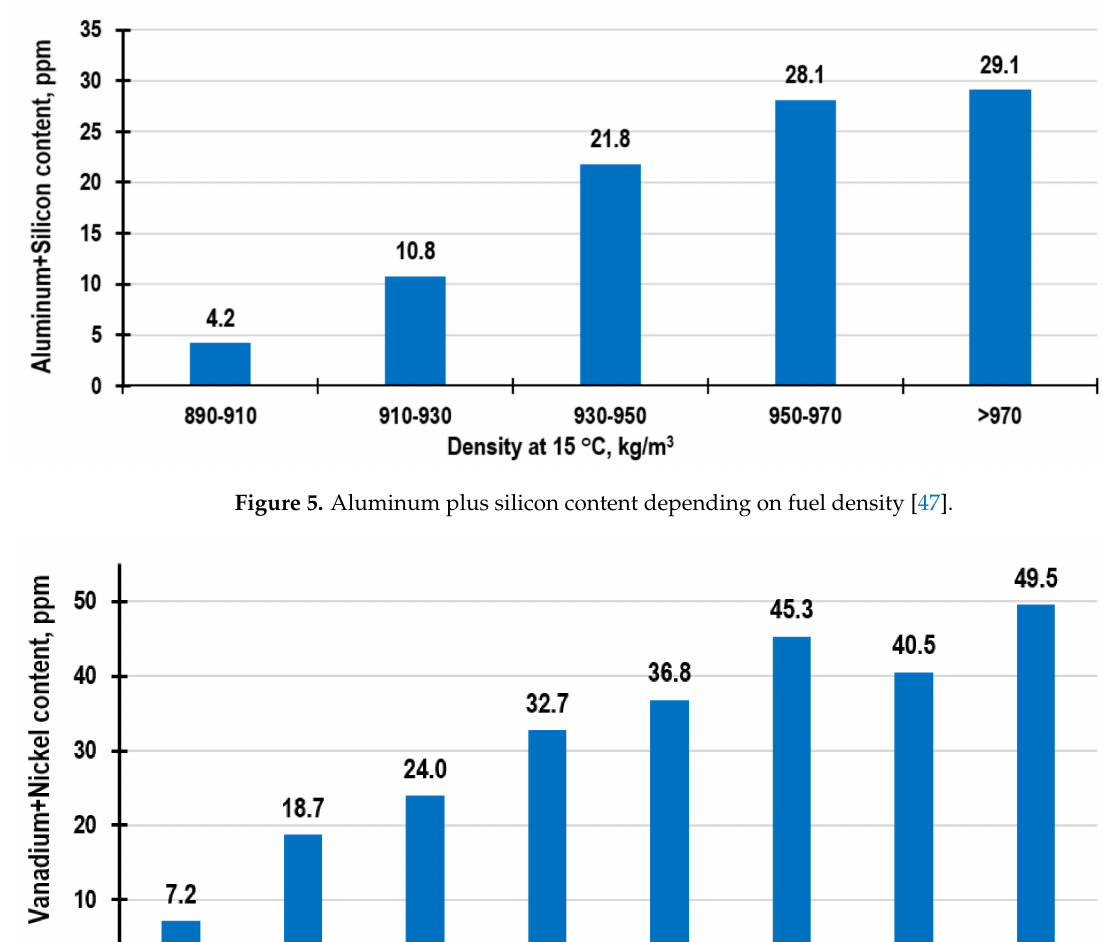
Figure 4. Aluminum plus silicon content depending on fuel viscosity [46].